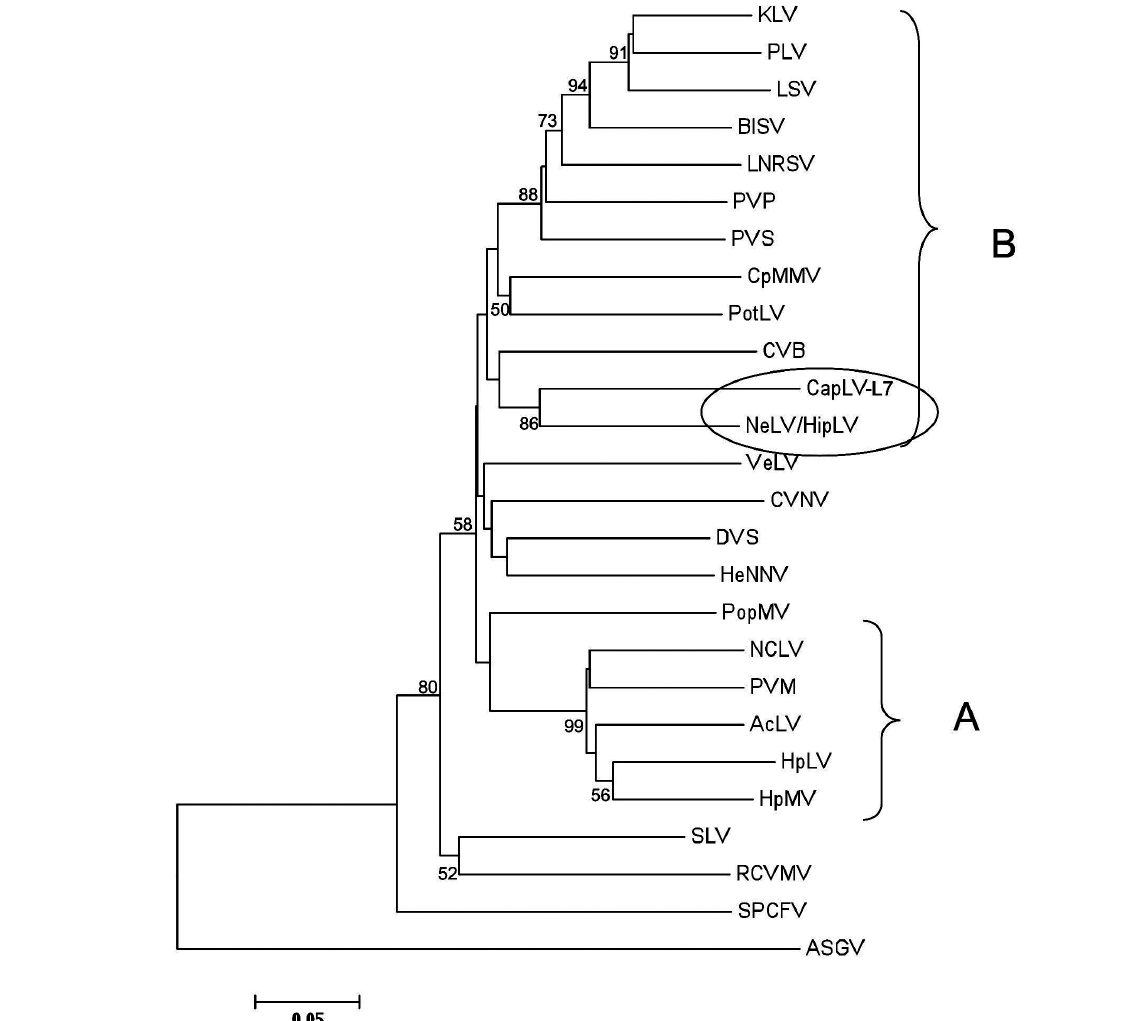
Figure 1. Phylogenetic relationships for amino acid partial sequences of the partial polymerase (ORF1) of the caper carlavirus (CapLV-L7) and other carlaviruses. The tree was bootstrapped using 10,000 replications and only boot- strap values greater than 50% are indicated. See text for full virus names and GenBank accession numbers of their nucleotide